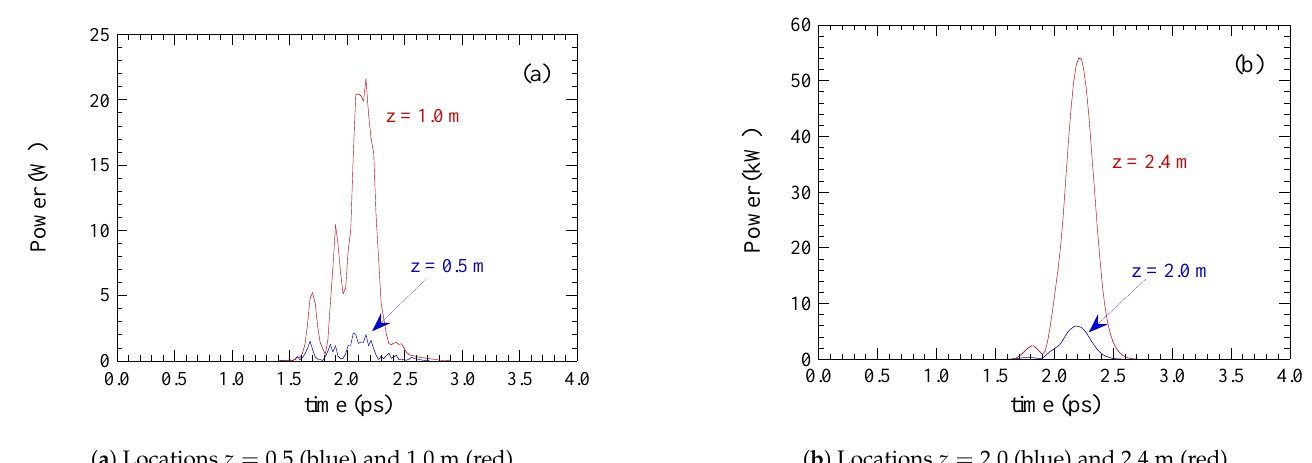
Figure 19. Temporal pulse shape at various locations along the undulator for the first pass when using a cavity detuning ∆ L cav = − 18 λ and an undulator field strength of B u = 6.658 kG ( K rms = 1.055). The other parameters are given in Table 1.